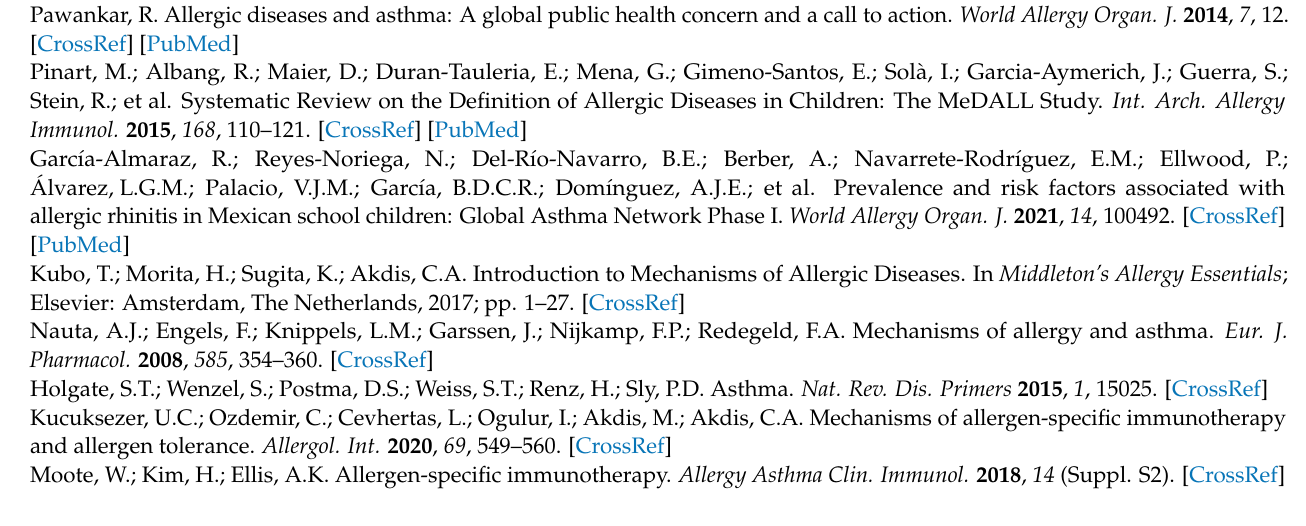
Table S1: Antibodies for FACS analysis of BALF cells; Table S2: Antibodies for FACS analysis of lung